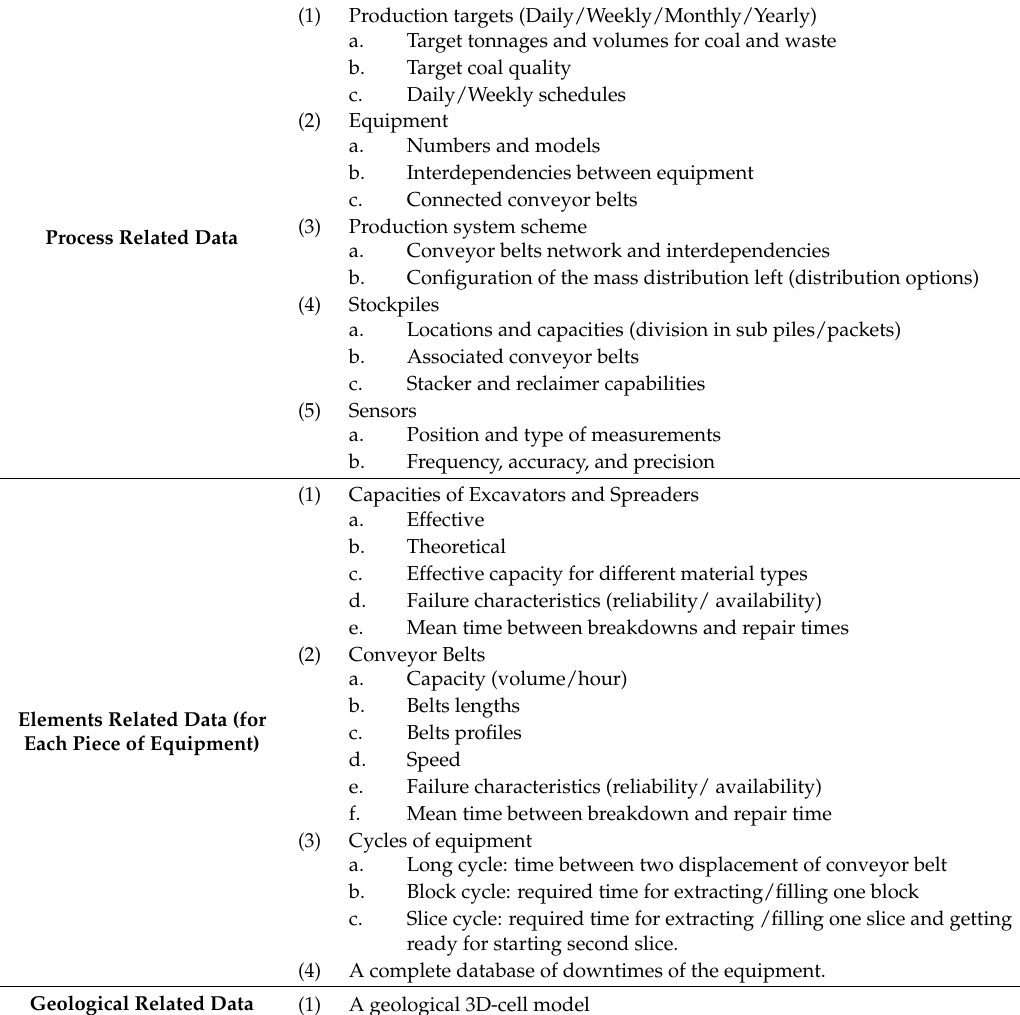
Table 4. The required data for building a simulation